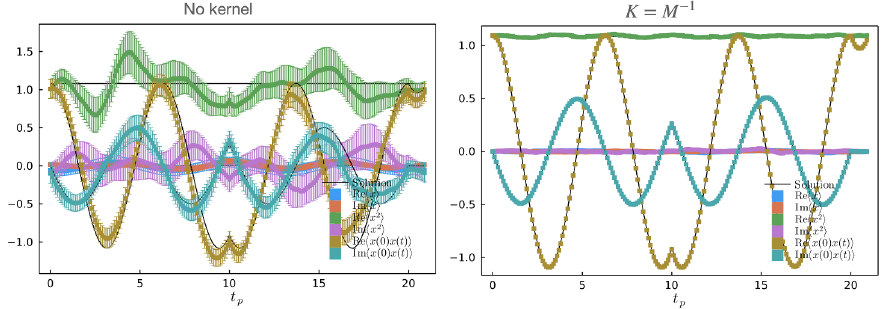
Figure 1. (left) The CL dynamics of the harmonic oscillator on the SK contour with real-time extent mt max = 10 in the absence of a kernel. (right) Same system after introducing the manually constructed kernel of eq.